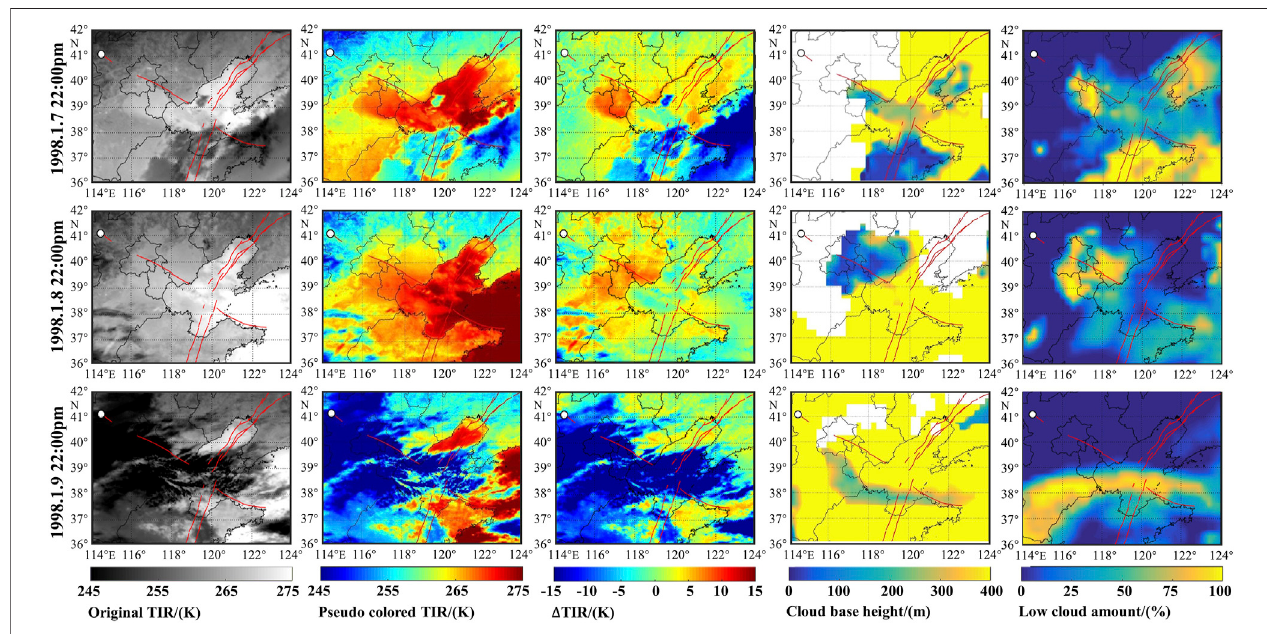
FIGURE 2 | The TIR and cloud images from January 7 to 9,